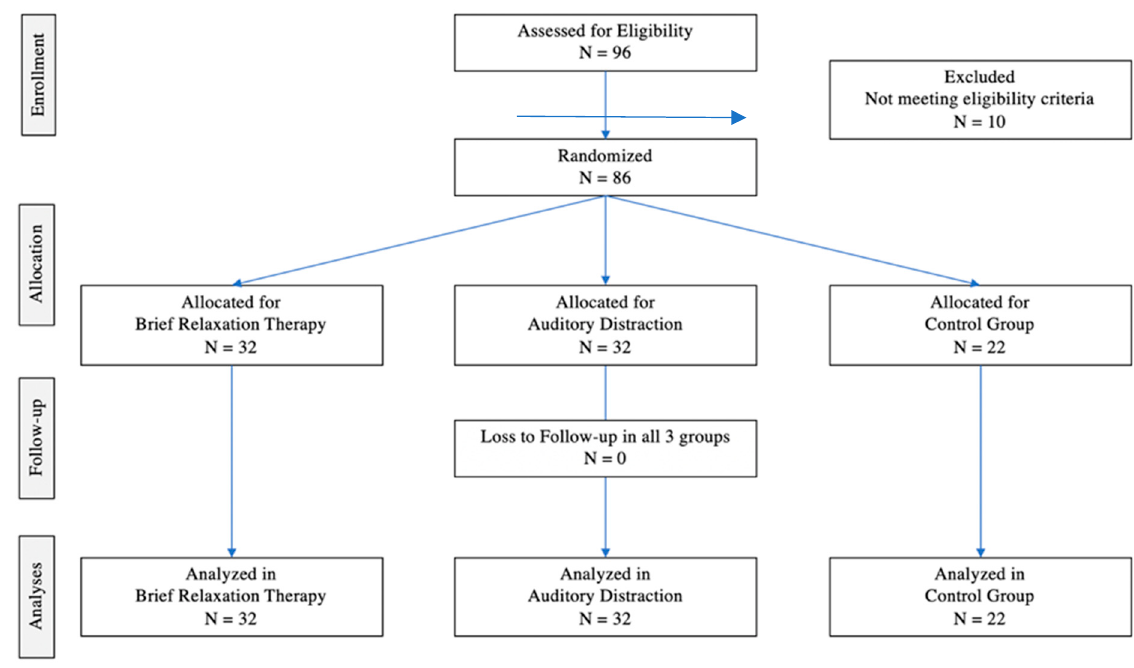
Figure 1. CONSORT flow diagram of the study.